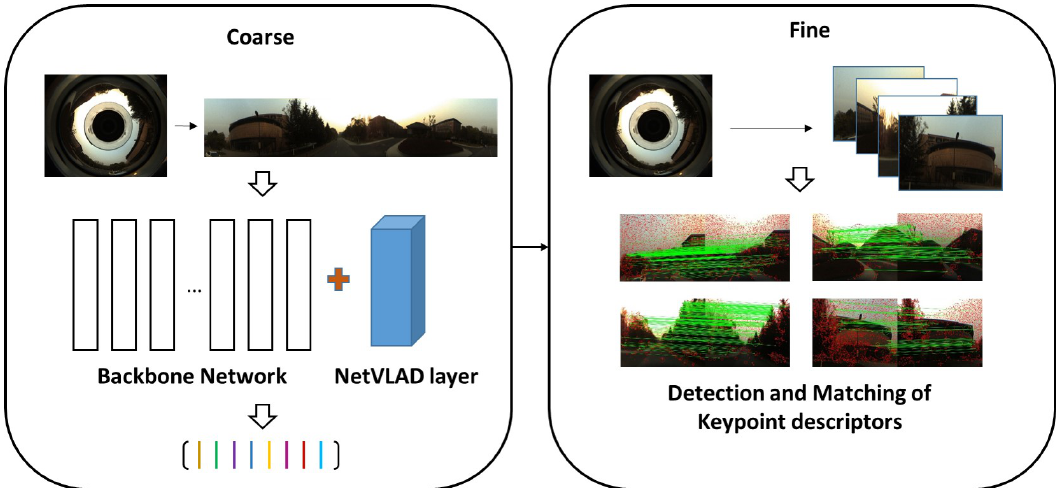
Figure 1. Overview of the proposed coarse-to-fine localizer. In the localization phase, NetVLAD descriptors and keypoint descriptors will be detected in the coarse stage and fine stage, respectively. After that, Brute Force (BF) matching and Fundamental Matrix mapping will be conducted,